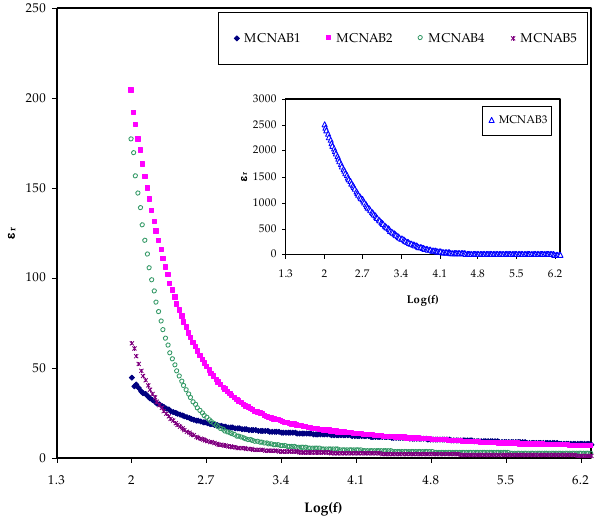
Figure 5. ε r against frequency at room temperature for each sample.